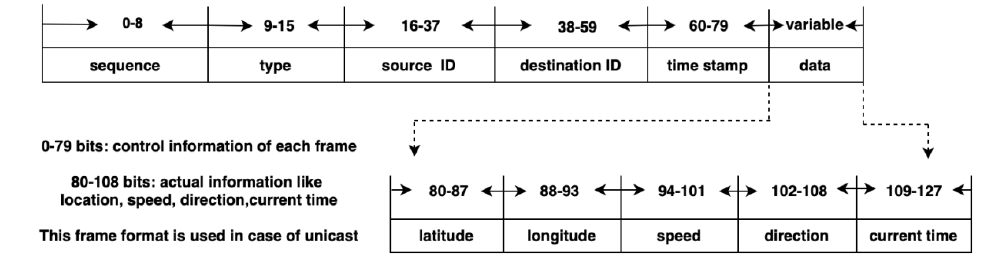
Figure 2. Flow diagram of packet forwarding at OBU.